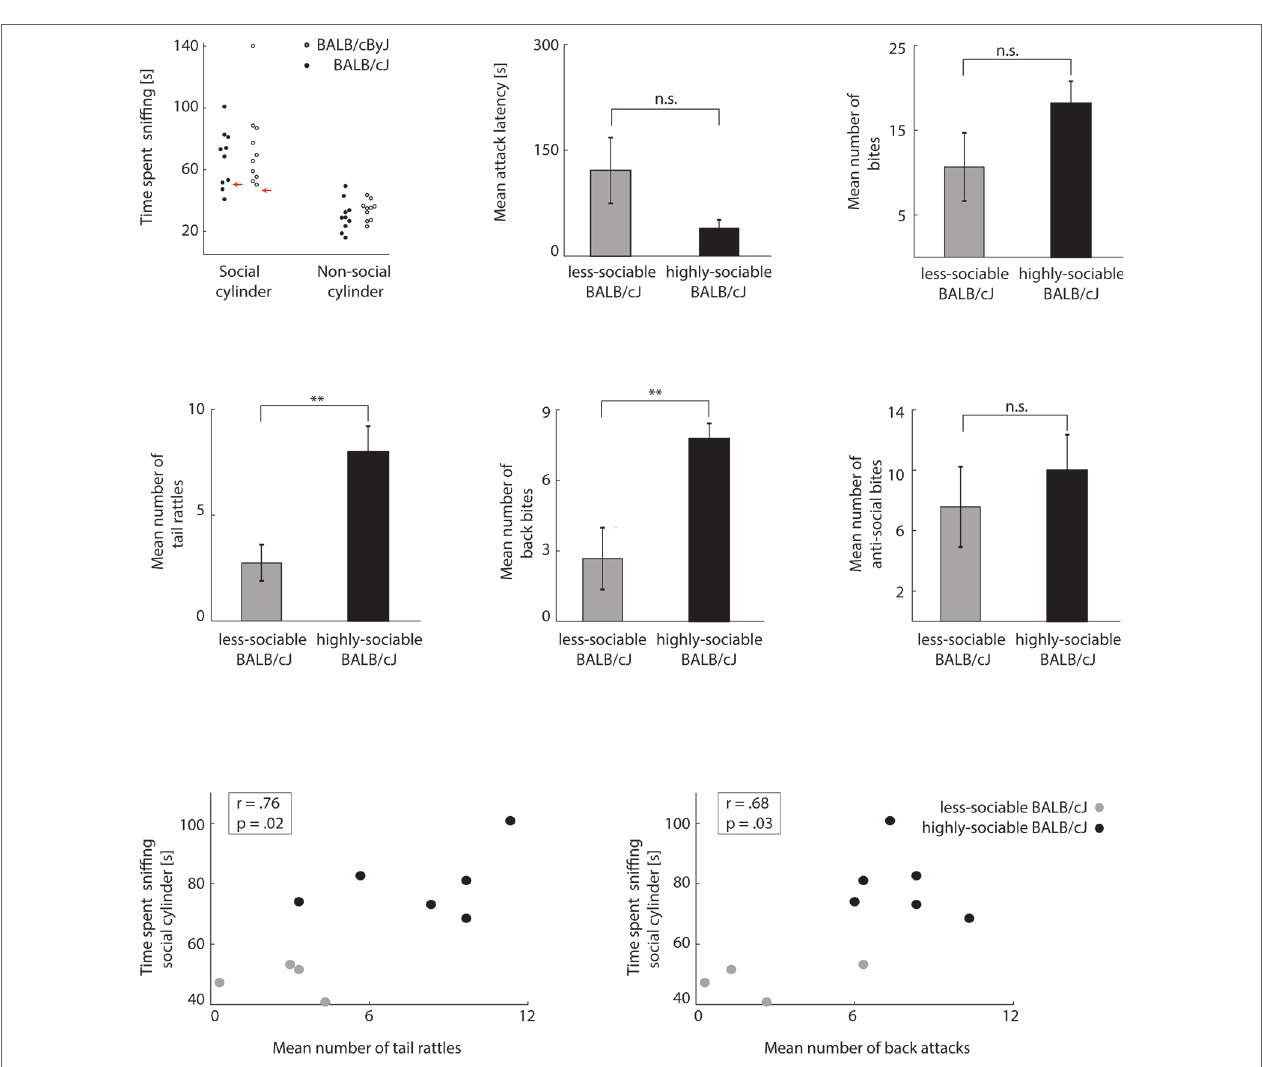
FIGUrE 2 | BALB/cJ mice can be split into two groups based on their sociability (A) Left panel: sniffing times of social and non-social cylinder in the 3CT test. Black dots: BALB/cJ mice. White dots: BALB/cByJ mice. Red arrows indicate average + 2 standard deviations of non-social cylinder sniffing time. Middle and right panel: average attack latency and number of bites of sociable and less-sociable BALB/cJ mice. Black bar: sociable BALB/cJ mice. Gray bar: less-sociable mice. Error bars: standard error of the mean (SEM). (B) Same as Figure 1B , but for sociable (black) versus less-sociable BALB/cJ mice (gray). (C) Correlation between social cylinder sniffing time and socially acceptable bites (left panel: tail rattles, right panel: back bites). Black dots: sociable BALB/cJ mice. Gray dots: less-sociable BALB/cJ mice. ** p < .01; n.s. = not significant.